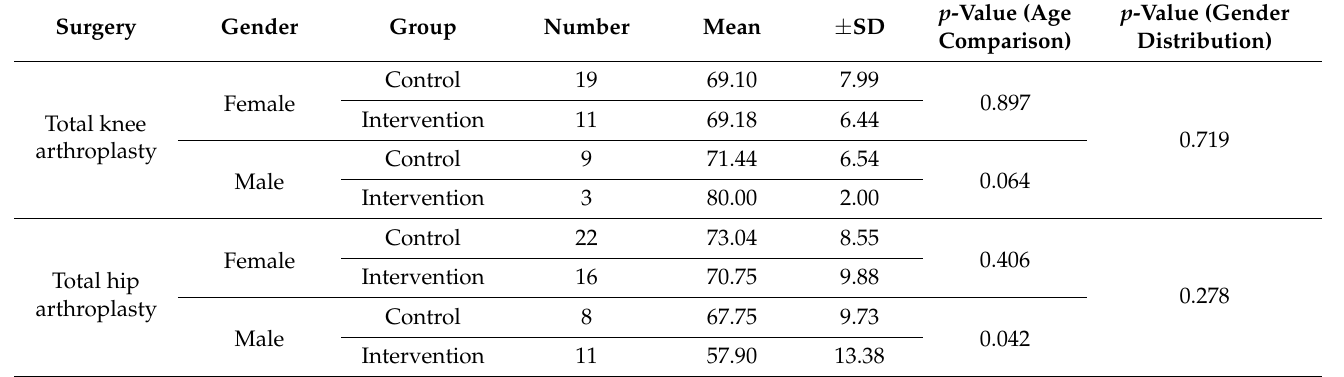
Table 1. Demographic data. Gender (female/male), age (mean ± SD), and p -value are shown for different